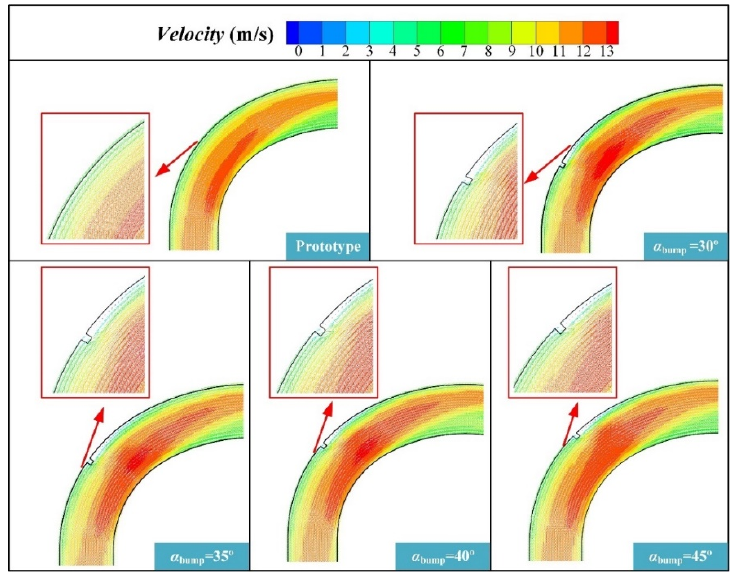
Figure 7. Flow field velocity vector diagram of the prototype bend pipe and the bend pipe with different positions of the bump.